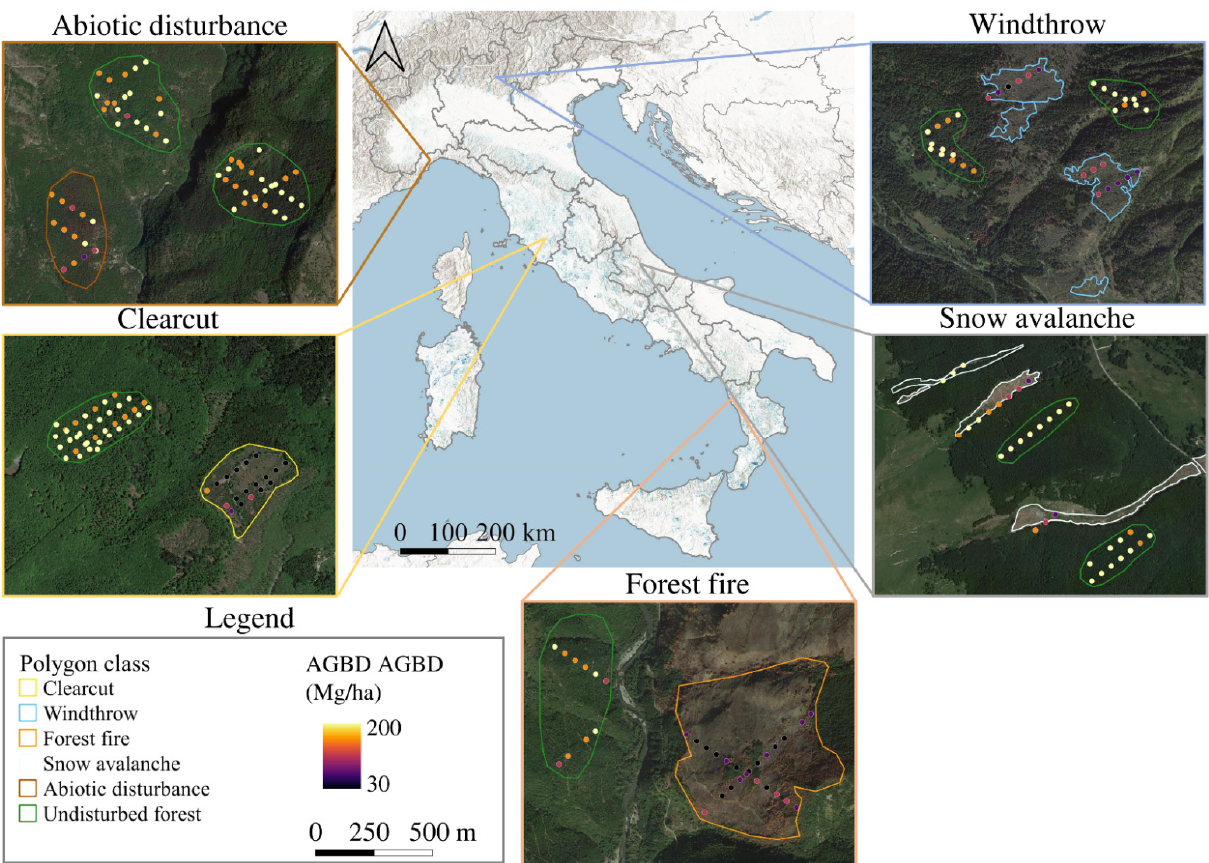
Figure 7. Comparison of AGBD between GEDI pulses acquired in 2019 over different kinds of forest disturbances that occurred in 2019.